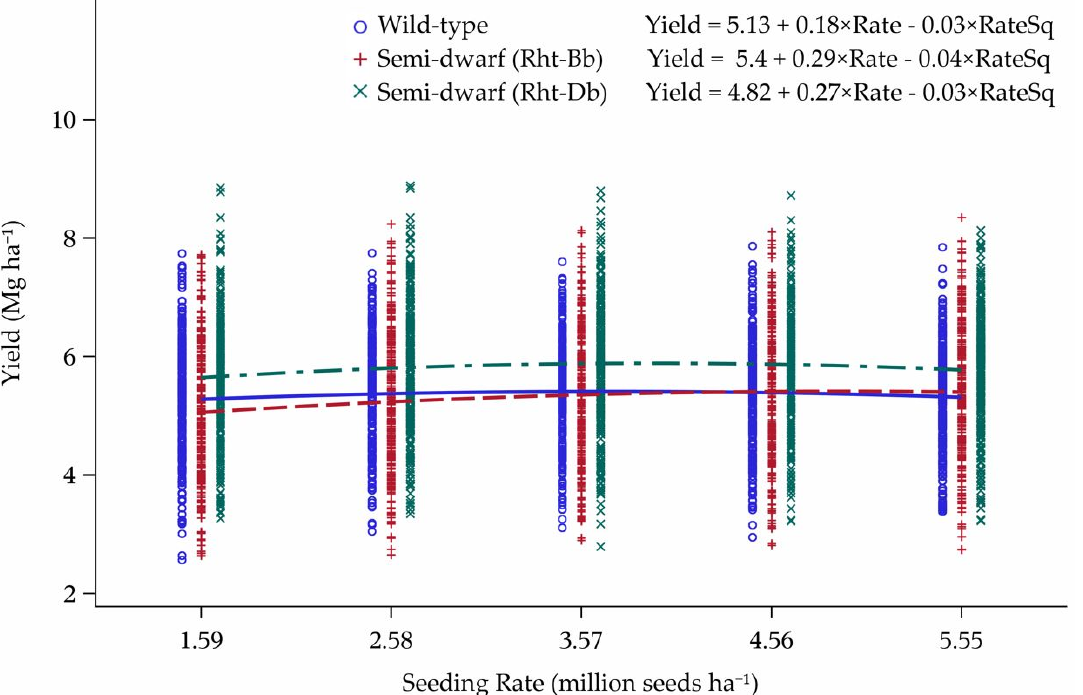
Figure 2. Influence of Rht-Bb , Rht-Db , and Rht-a (wild-type stature) alleles on yield response to seeding rate over 21 environments in Minnesota and North Dakota, 2013–2015. Seeding rate for the peak of the curve: Wild-type = 3.41, Rht-Bb = 3.21, and Rht-Db = 4.40 million seeds ha − 1 . The Ppd-Da allele for photoperiod insensitivity (PI) and Ppd-Db allele for photoperiod sensitivity (PS) imparted no yield advantage at any seeding rate when averaged over 21 environments for the six cultivars comprising each allele group (Table 4). Table 4. Regression summary of Ppd-D allele influence on yield response to seeding rate over 21 environments in Minnesota and North Dakota, 2013–2015.